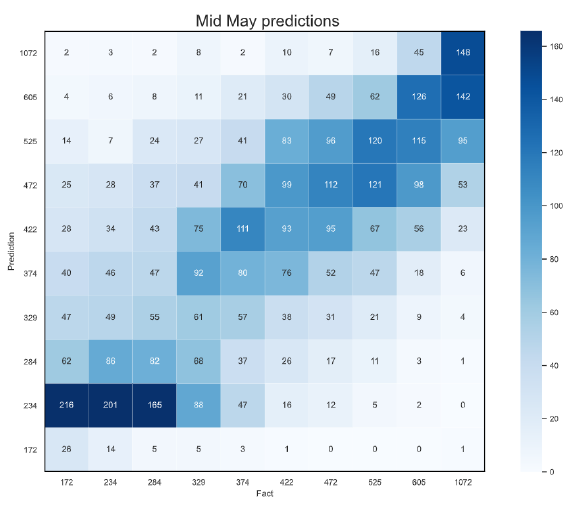
Figure 19. Early Predictions: